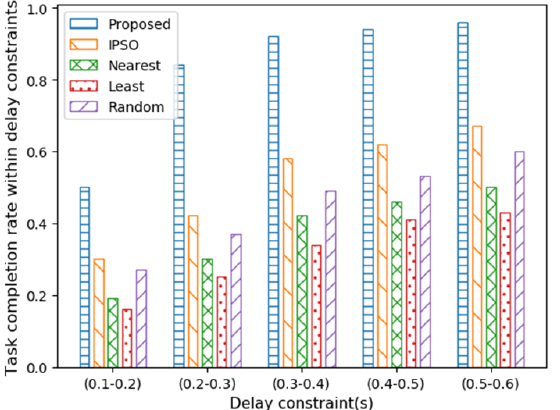
Figure 7. Task completion rates for delay constraints.